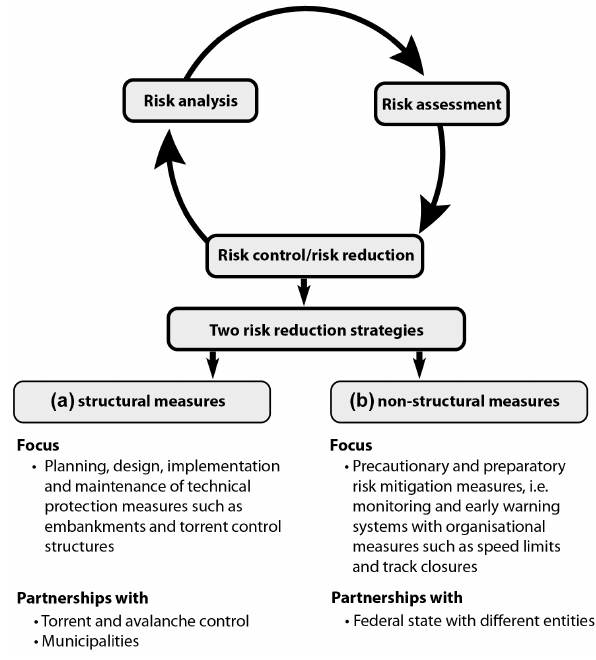
Figure 1. Risk management cycle and strategies of the